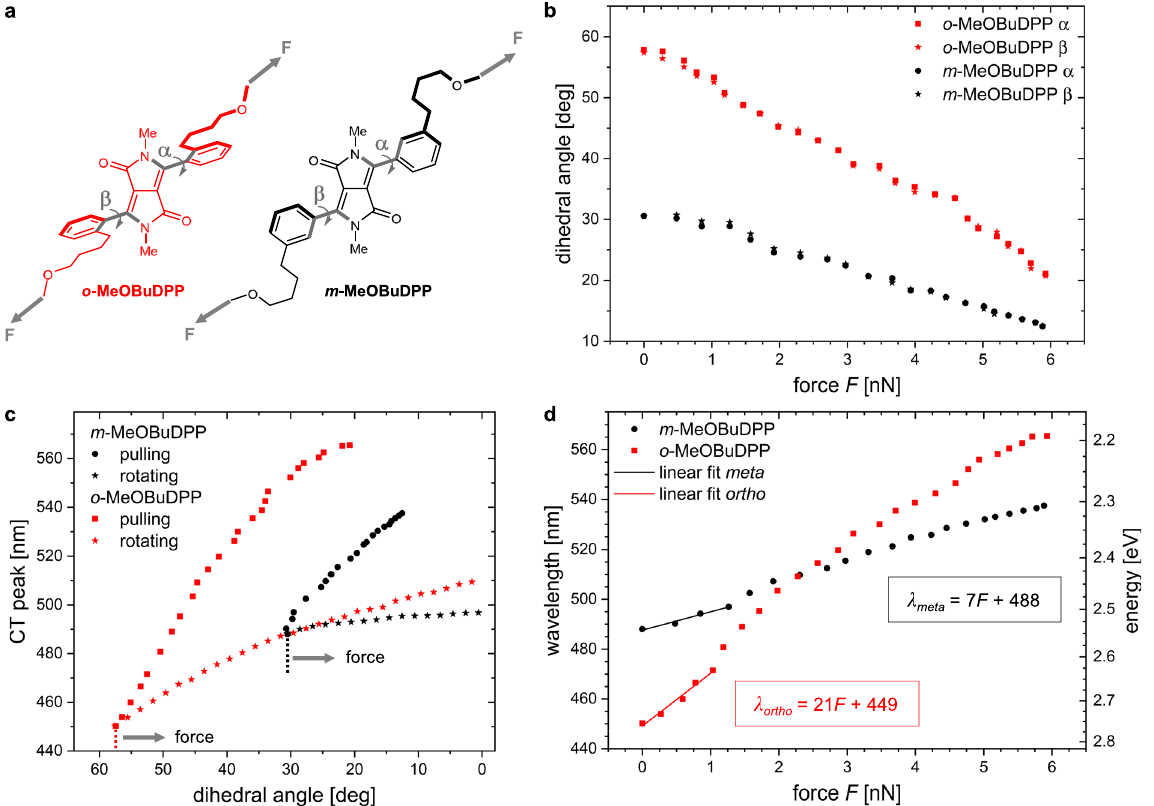
Fig. 3 Theoretical elongation of the DA spring. a Structures of the ortho -4-methoxybutyl and meta -4-methoxybutyl functionalized DA spring (MeOBuDPP) for theoretical investigations. b Calculated relation between external elongational force ( F ) and the dihedral angles α , β between Ph and DPP core. c Analysis of the contributions from changes in the dihedral angles and deformation of the structure on the optical properties. d Calculated relation between F and both wavelength and energy of the charge-transfer absorption band of o- / m-